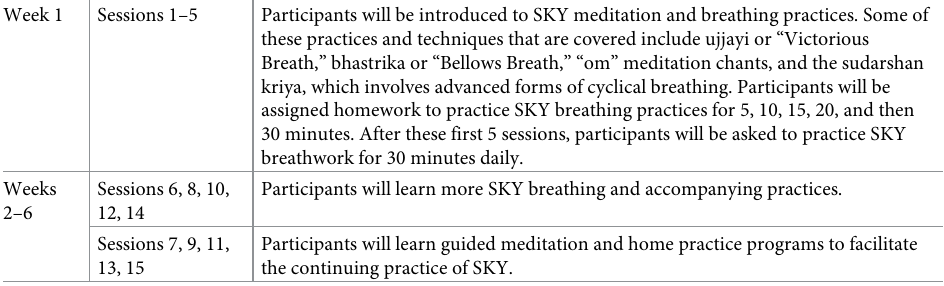
Table 3. A description of the 6-week Sudarshan Kriya Yoga intervention.